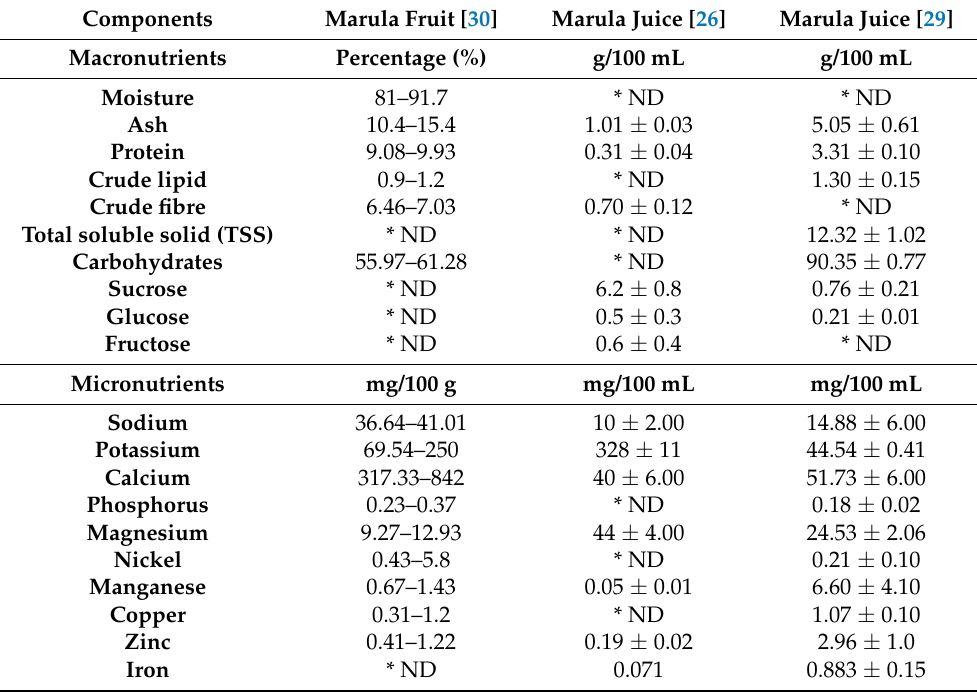
Table 1. Proximate analysis of marula fruit and juices.